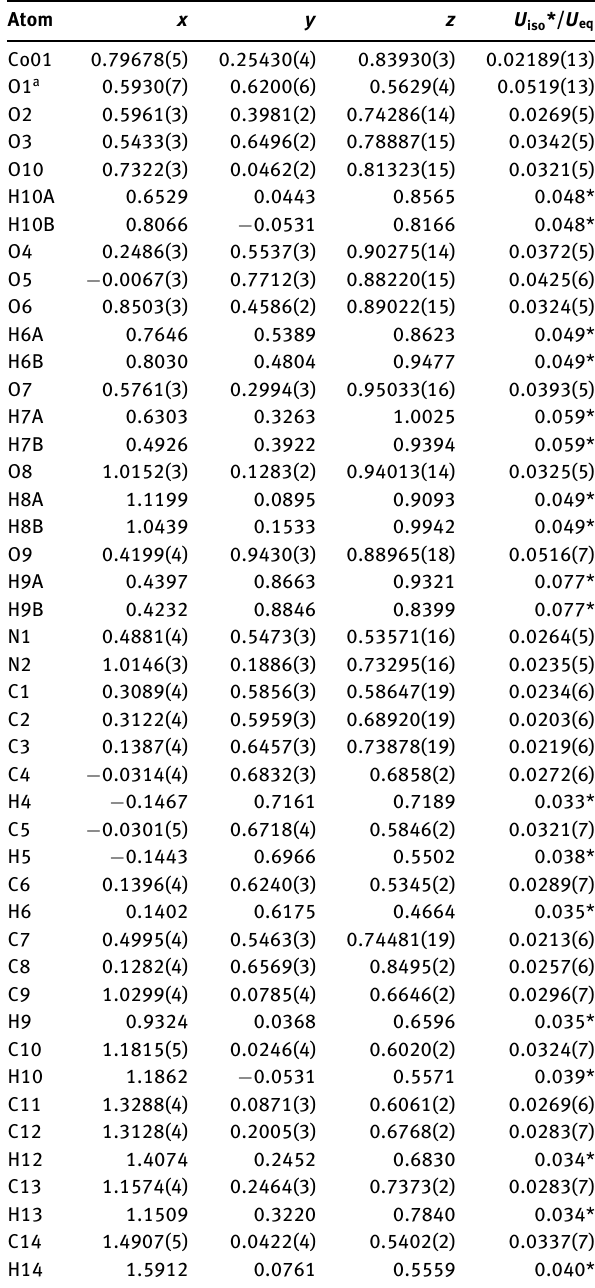
Table 2: Fractional atomic coordinates and isotropic or equivalent isotropic displacement parameters (Å 2